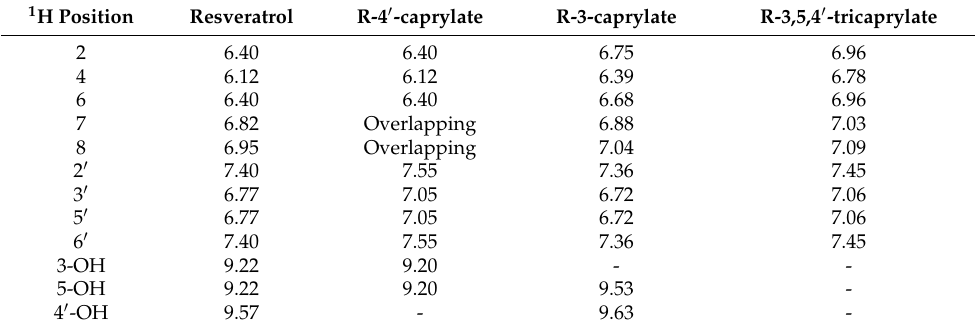
Table 2. 1 H chemical shift ( δ ) of resveratrol, resveratrol